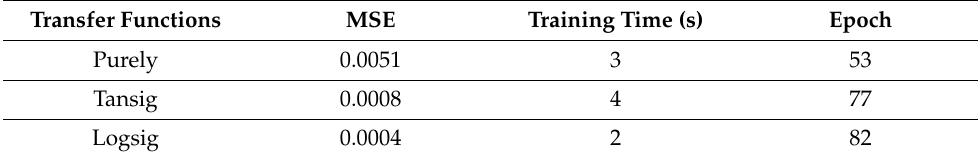
Table 7. Influence of transfer functions.